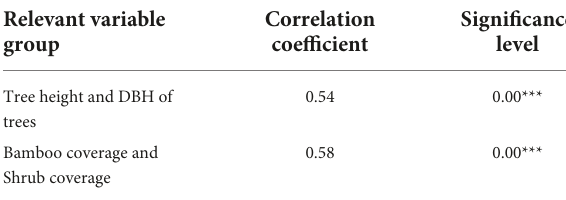
TABLE 3 Variable groups with correlation coefficients exceeding 0.5 and corresponding significance level.